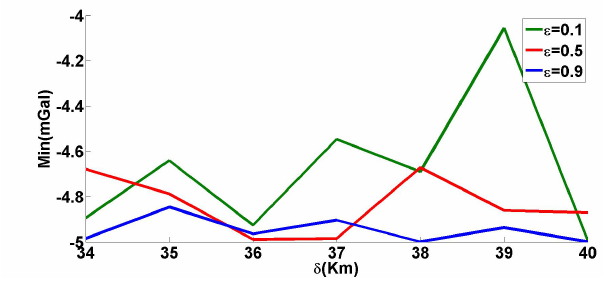
Fig. 6. Minimum of the differences between SMLS approximated values and those from shipborne gravimetry, as a function of δ , Gaussian weight function, ϵ = 0.1, 0.5, 0.9